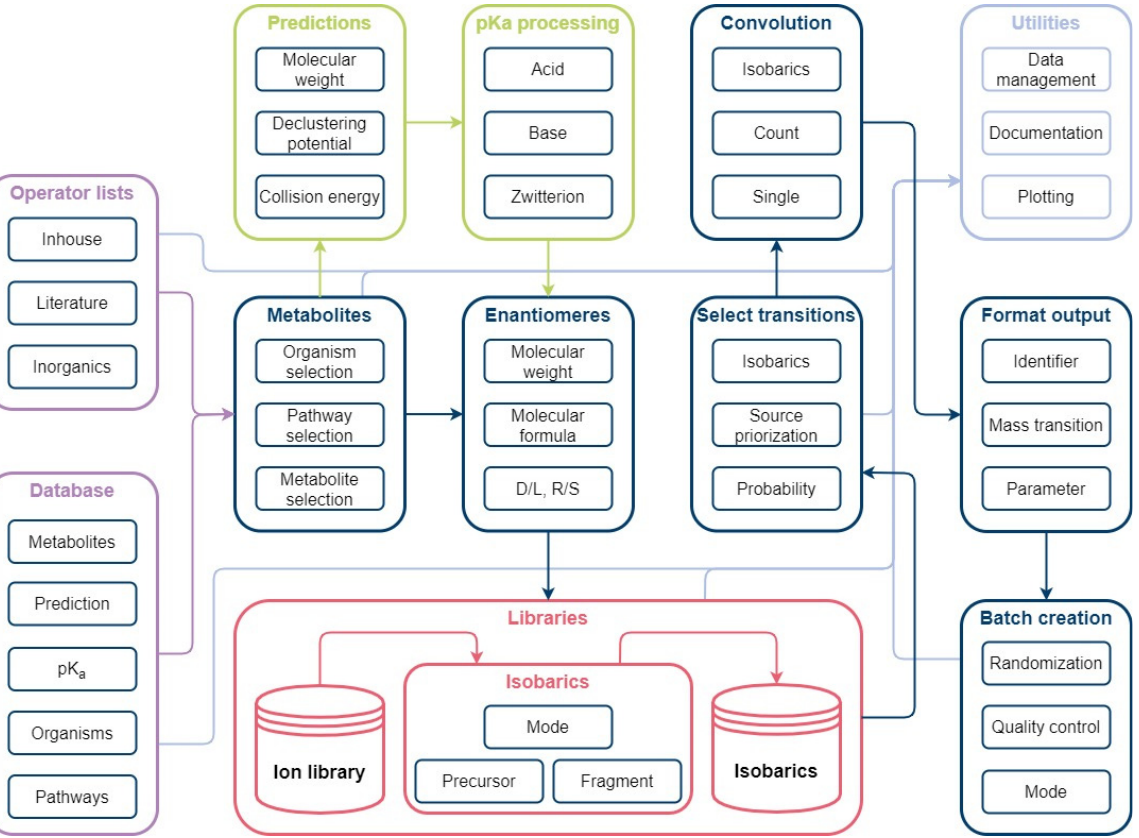
Figure 9. Automated method development workflow: The workflow consists of the main modules Metabolites, Enantiomers, Libraries, Select transitions, Convolution, Format output, and Batch creation. The Metabolites module is used for organism-specific selection of database information. A simple enantiomer selection is applied prior to ion library creation. Mass transitions are evaluated based on possible isobaric fragmentation patterns per ionization mode and subsequently selected in the Select transitions module. Unavoidable convolutions are considered for method creation to avoid false positives. Selected mass transitions are formatted for instrument use. Measurement lists can be generated automatically using the batch creation function.